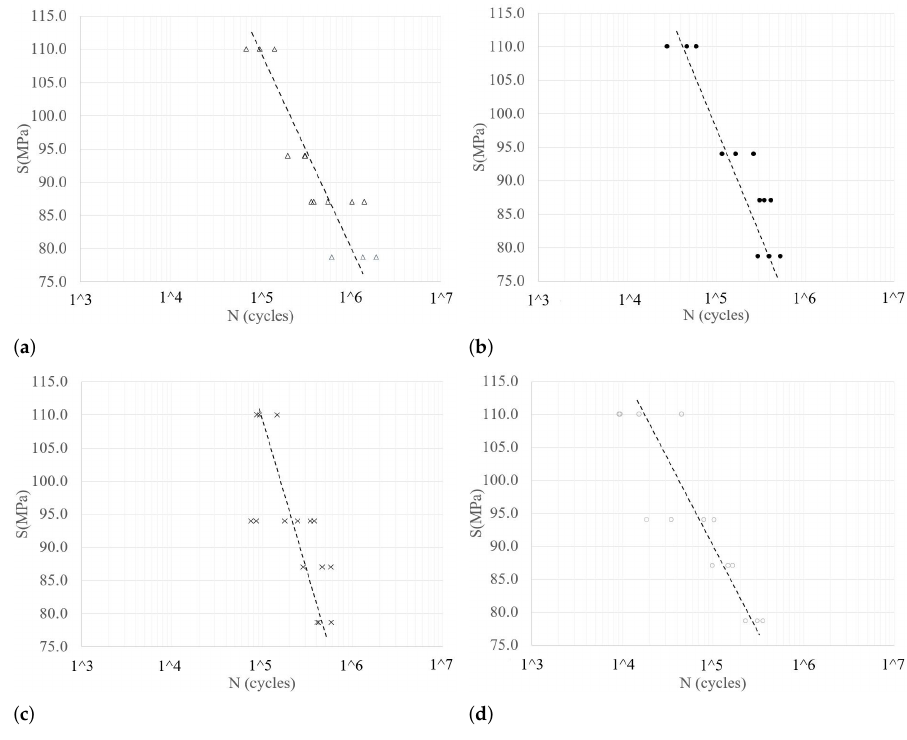
Figure 6. Experimental fatigue results: ( a ) batch 1; ( b ) batch 2; ( c ) batch 3; and ( d ) batch 4. Crack positions were analyzed to identify any pattern, as shown in Figure 7. The alloy components have an effect not only on developing resistance to static loads but also in the manufacturing process of the present casting study, which requires that the material flow uniformly avoids the generation of voids in the component, and that an adequate filling undergoes uniform cooling to develop the homogeneous structure. In components with inclusion, the alumina ( OAl ) is located in failure.